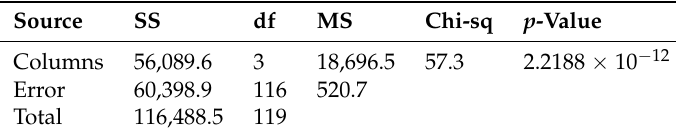
Table 4. F1 score Kruskal–Wallis test.